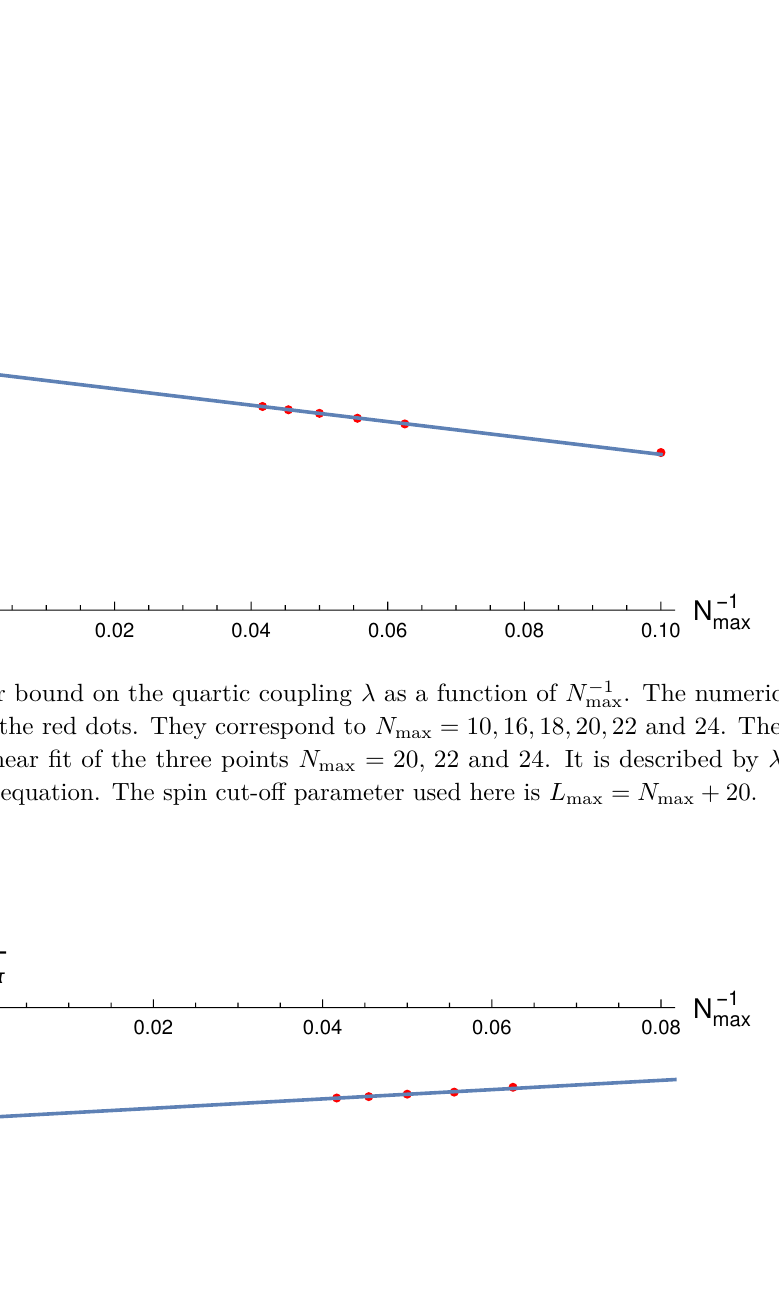
. The numerical results max